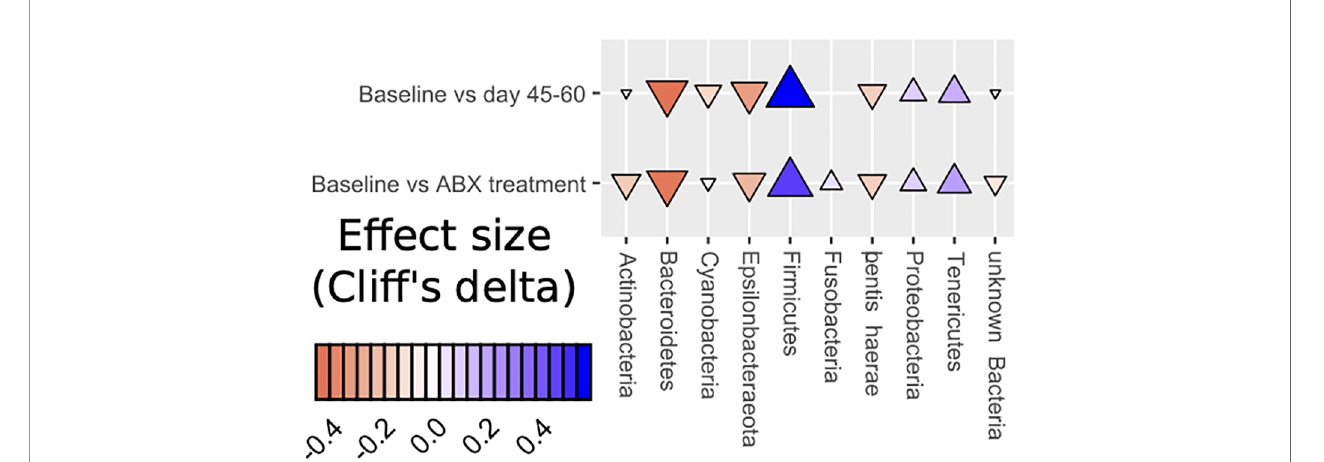
FIGURE 6 | Dynamics of changes in abundance at the phylum level (Effect size Cliff ’ s delta).